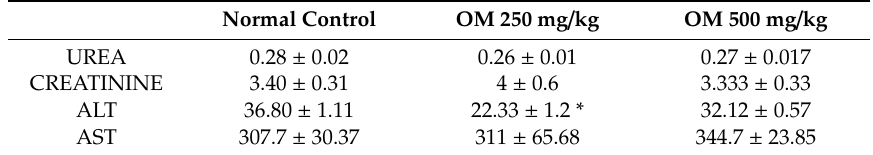
Table 2. Effect of sub-acute administration of OM on biochemical parameters in male mice (n = 5). Normal